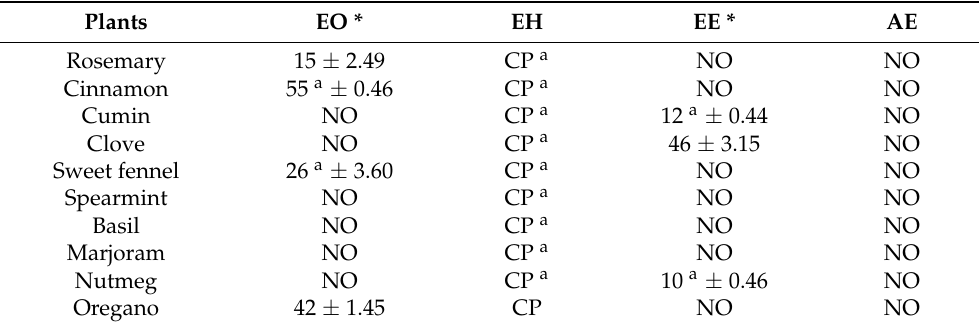
Table 2. The inhibitory effect of essential oils and extracts on Aspergillus carbonarius growth using the measurement of the diameter of inhibition zone in mm using the agar diffusion